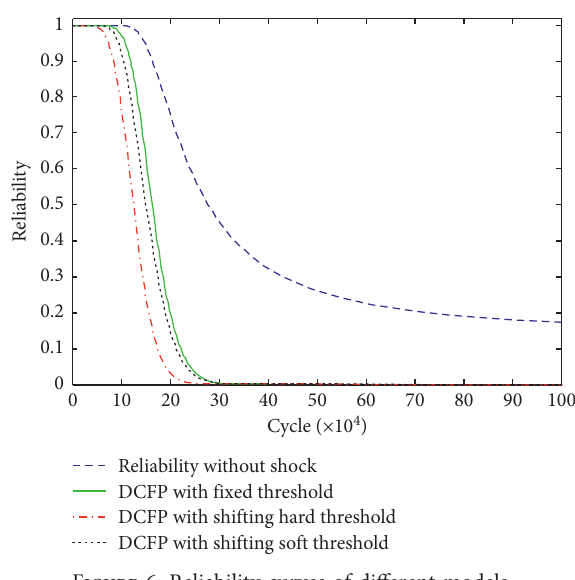
Figure 6: Reliability curves of different